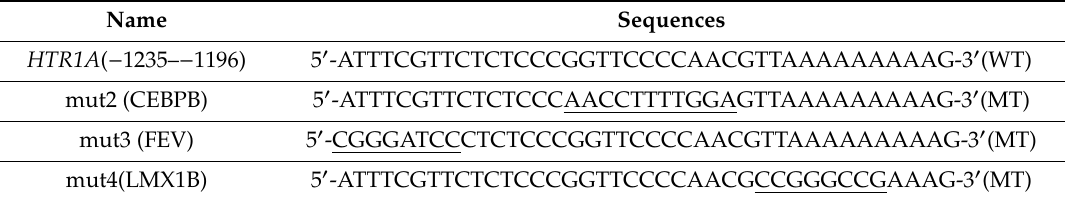
Table 1. Sequences of the probes in the electrophoretic mobility shift assay